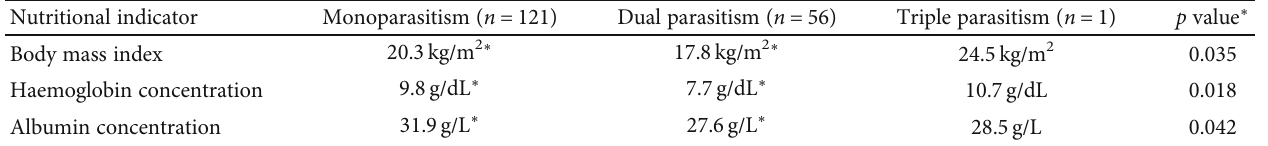
Table 6: Di ff erences in haemoglobin, albumin levels, and BMI in categories of parasitism. Nutritional